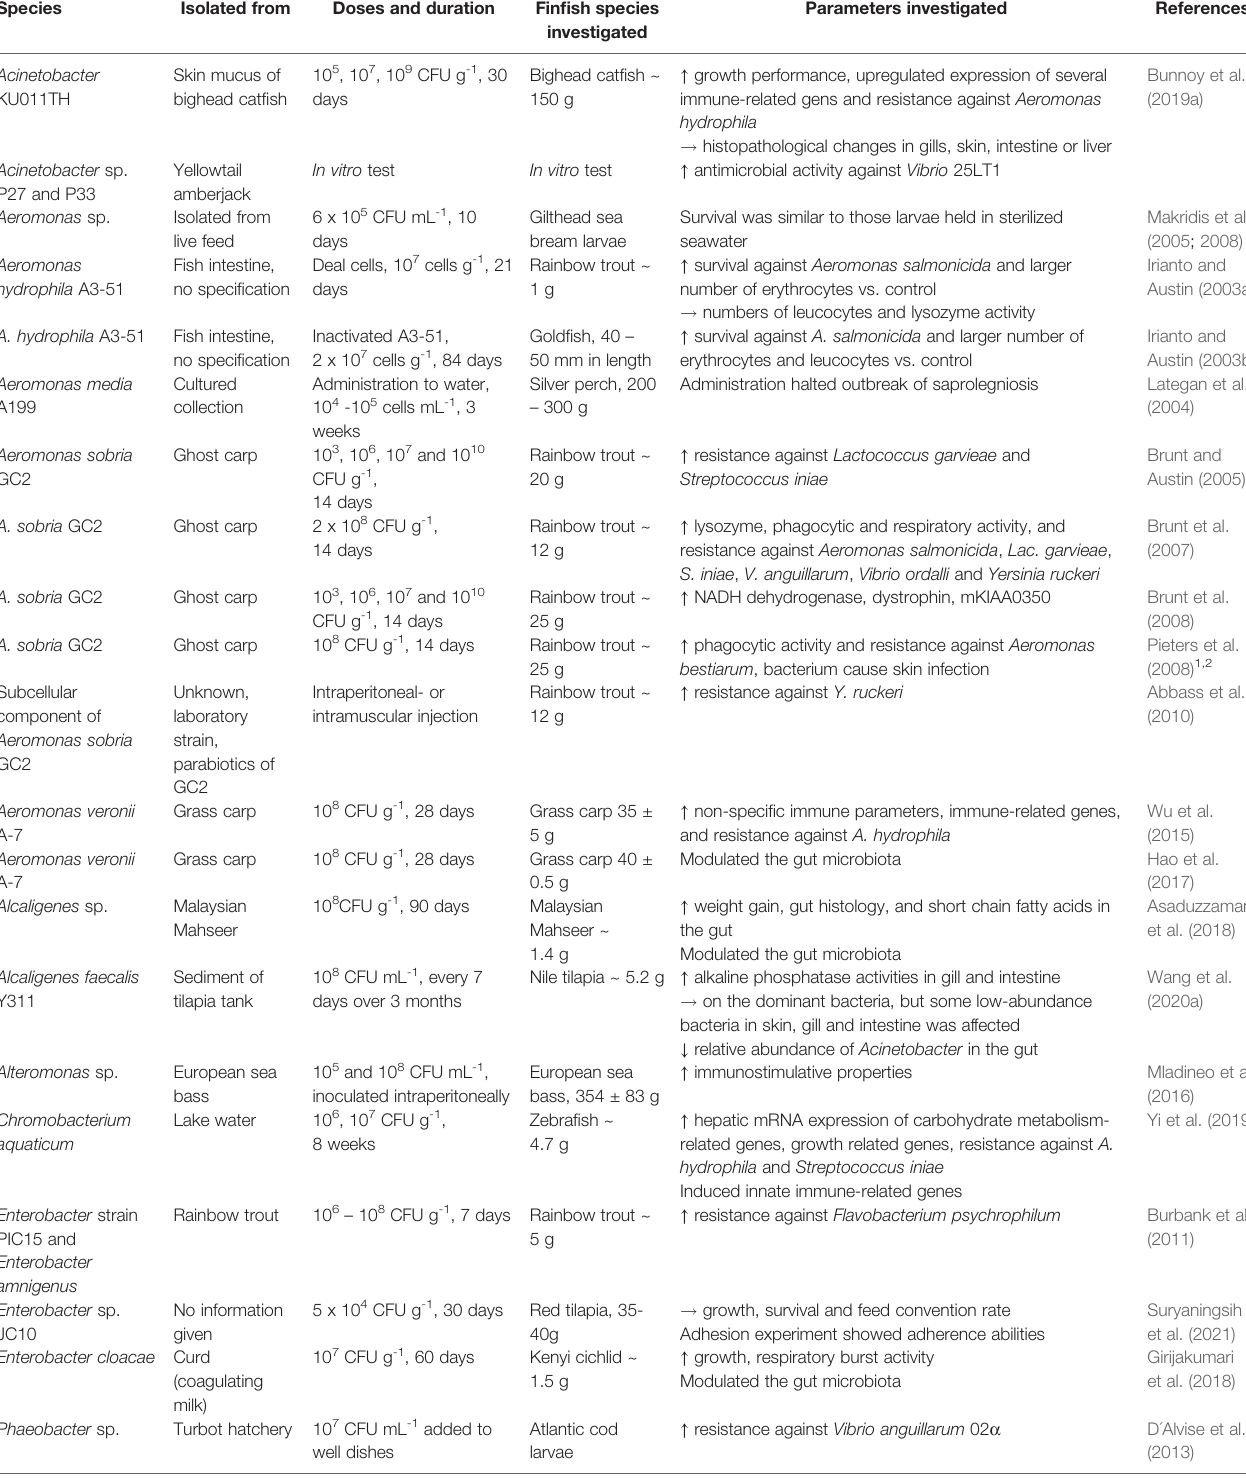
TABLE 1 | Effect of Gram-negative bacteria on growth performance, gut health, immune system and disease resistance in fi n fi sh, and some in vitro studies. Species